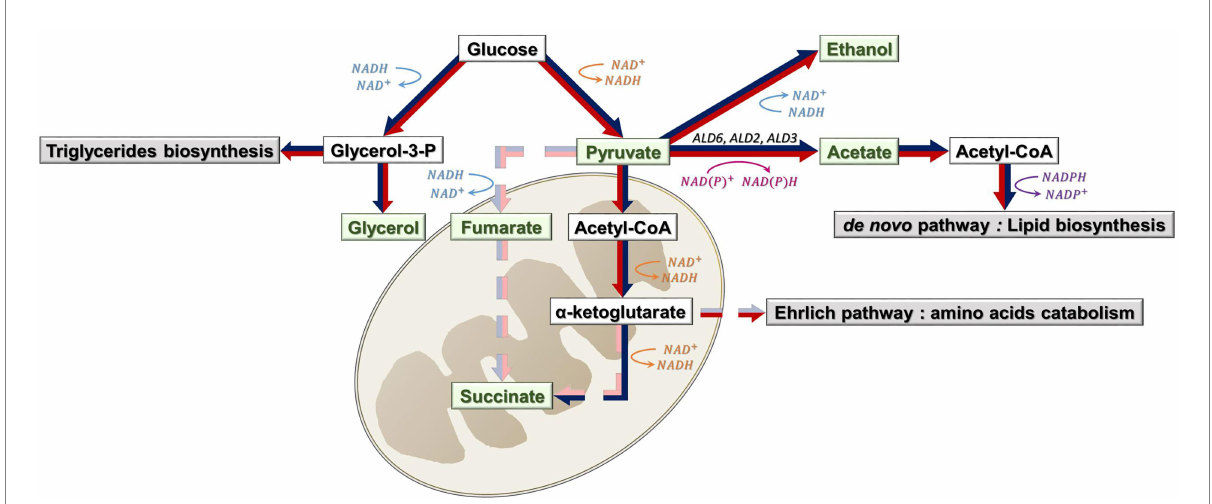
FIGURE 6 Biosynthesis of CCM metabolites (green) and associated pathways (gray) under sterol limitation and high sugar content. Possibly active pathways under sterol limitation are represented with red arrows; Possibly active pathways under high sugar content are represented with dark blue arrows; possibly inactive pathways are represented with dashed arrows (red for sterol limitation and blue for high sugar content). Reduction reactions are in orange and pink; oxidation reactions are in blue and purple. ALD6 , ALD2 and ALD3 are genes involved in acetate